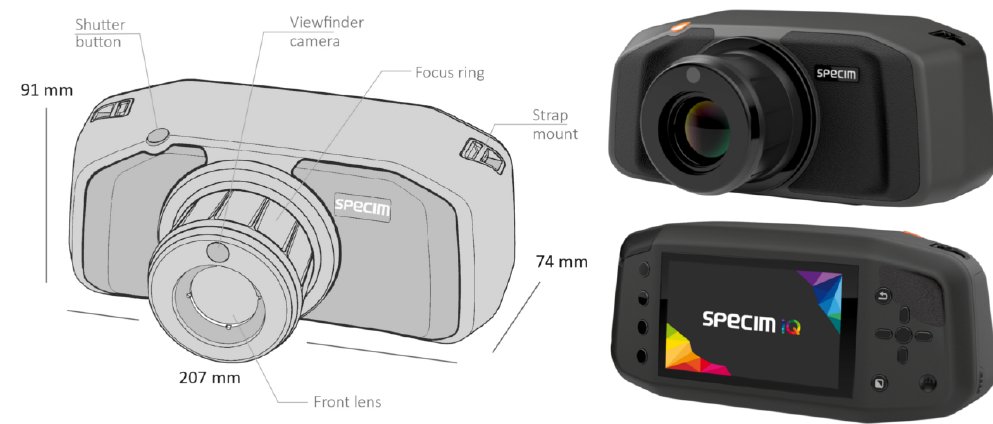
Figure 1. Vector visualization of the Specim IQ (Specim Ltd., Oulu, Finland) with annotations and dimensions on the left side and RGB renderings on the right